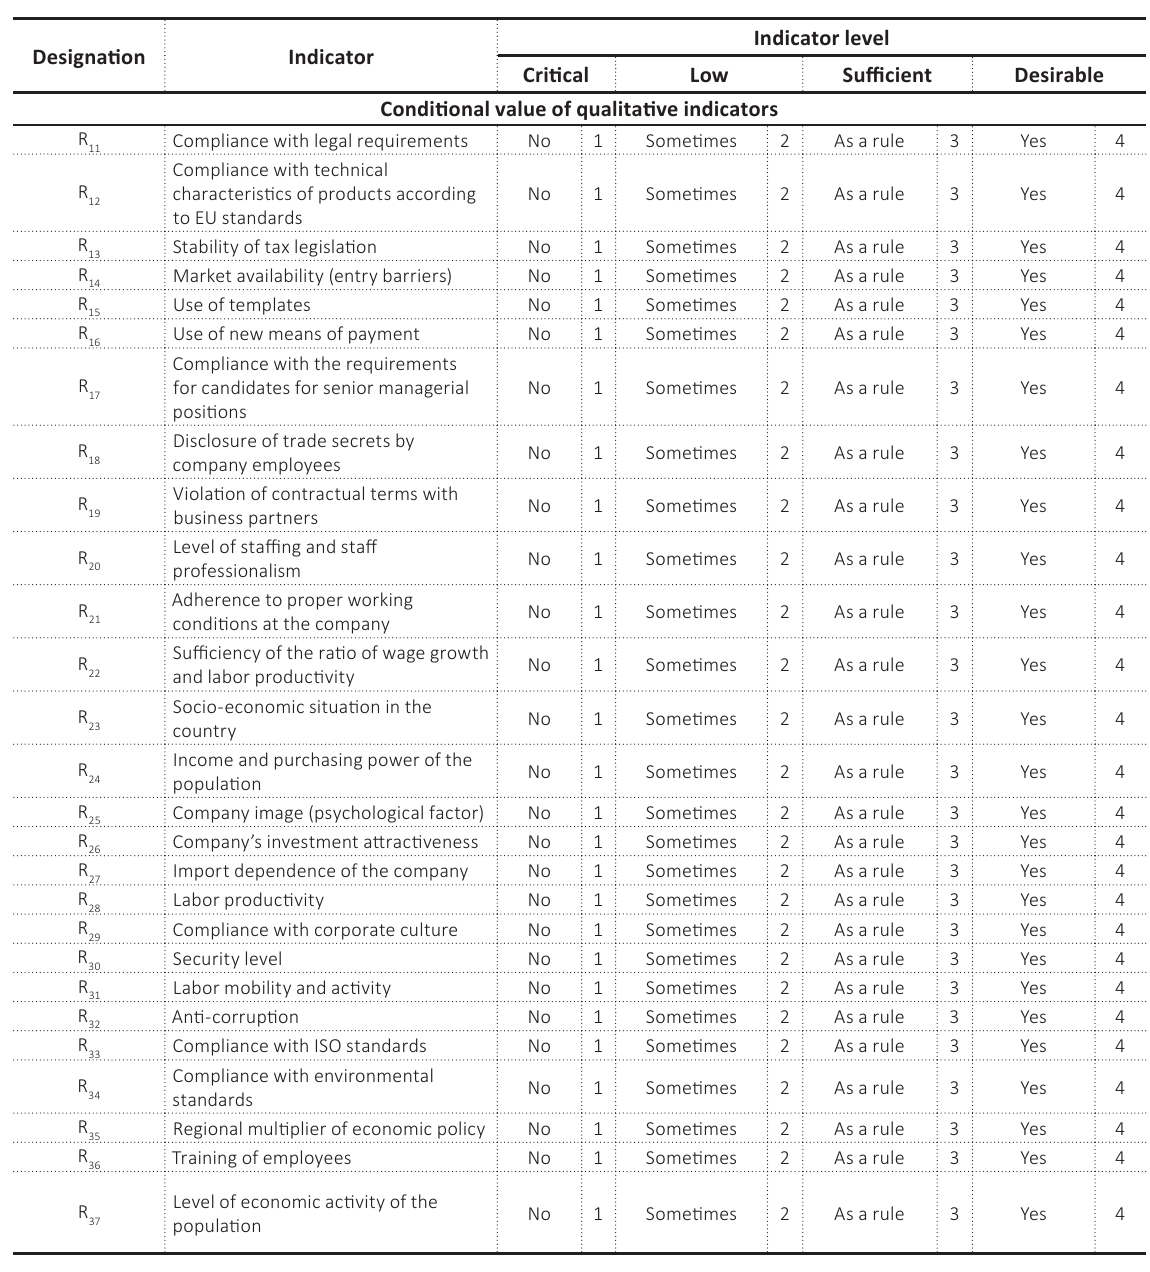
Table 3 (cont.). Indicator